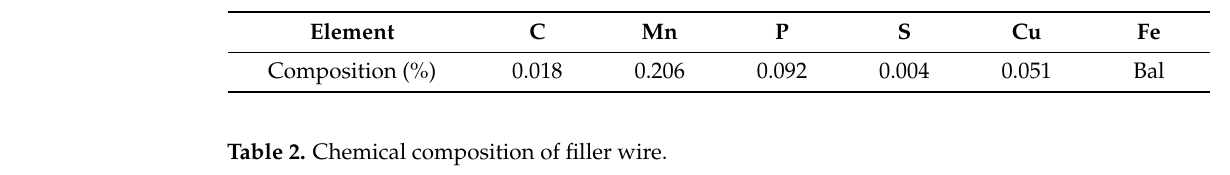
Table 1. Composition of the SPCC steel.